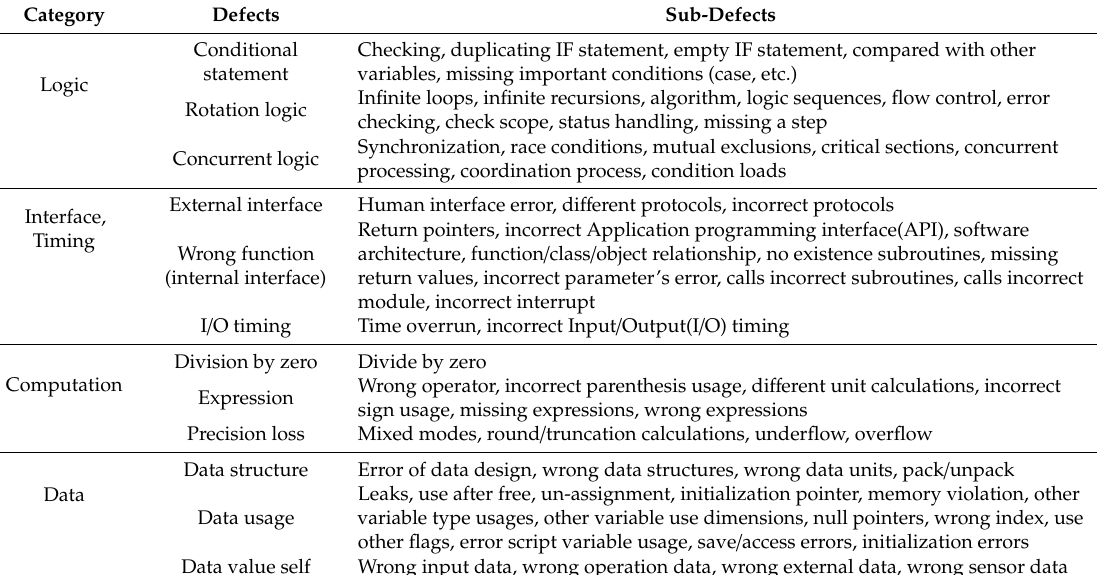
Table 2. Huh and Kim’s [5] classified list of pure software